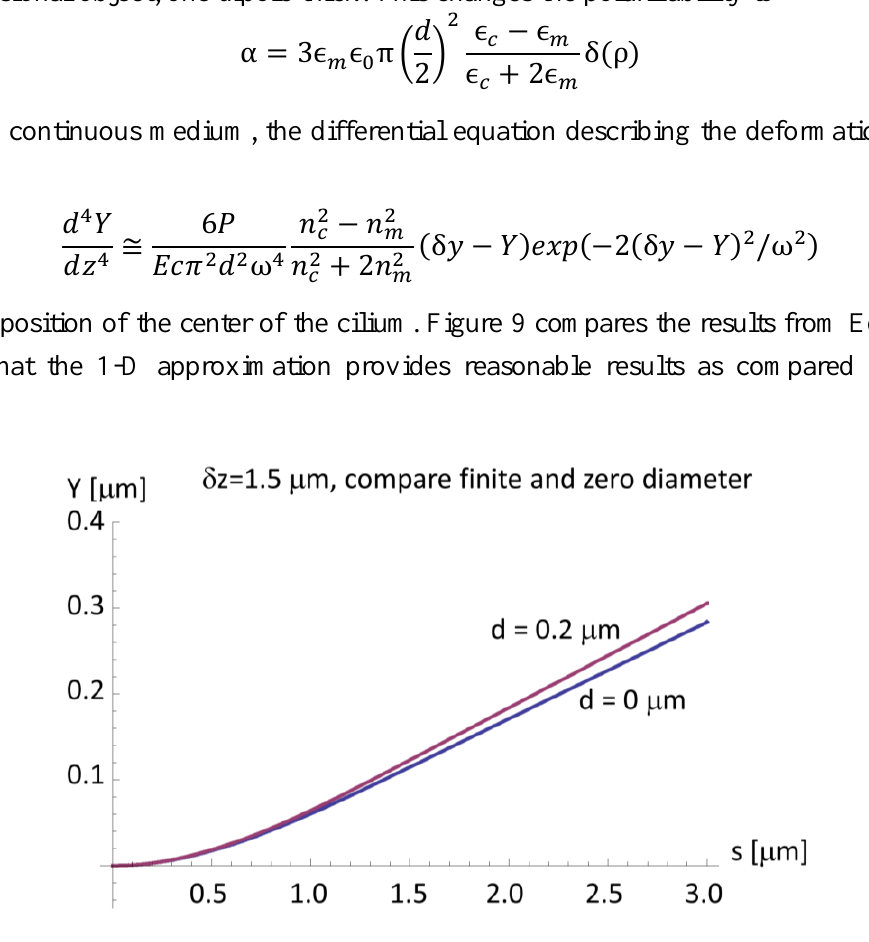
Figure 9. Example deformation of a primary cilium for a representative experiment, showing the effect of idealizing the primary cilium as a 1-D object. Finite cilium diameter (red), the 1-D idealized approximation (blue). The trap parameters: incident power P = 0.5 W, trapping lens numerical aperture NA = 0.95, and trap wavelength λ 0 = 1.064 µm. The trap center was displaced from the cilium axis by δy = 0.5 µm and δz = 1.5 µm. The cilium length is 3.0